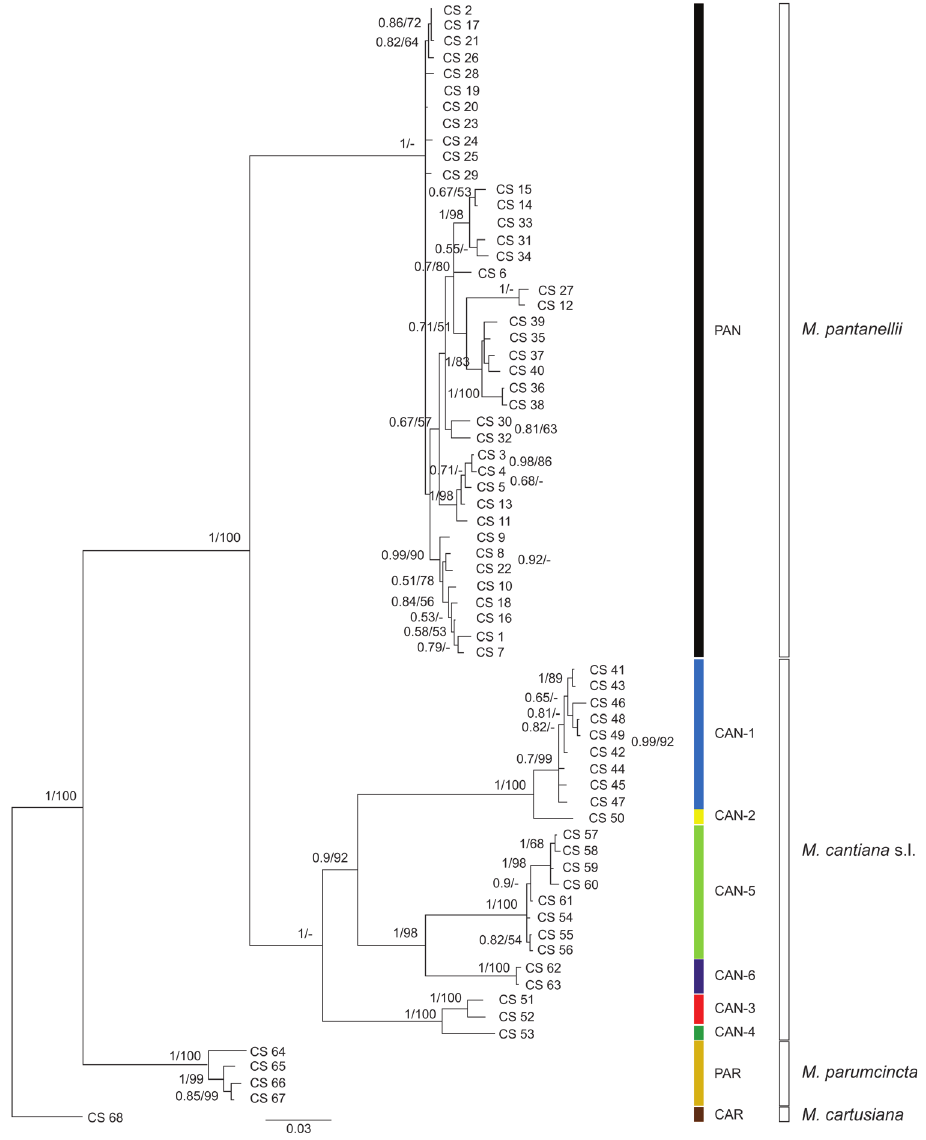
Figure 4. Bayesian 50% majority-rule consensus tree of the concatenated data set of COI and 16S rDNA haplotypes, and ITS2 and H3 common sequences (see Table 4). Sequences of M. pantanellii were compared with appropriate sequences of M. cantiana s. l. and M. parumcincta obtained from GenBank (Tables 2, 4). Posterior probabilities (left) and bootstrap support above 50% from ML analysis (right) are indicated next to the branches. Bootstrap analysis was run with 1000 replicates (Felsenstein 1985). The tree was rooted with M. cartusiana concatenated sequences obtained from GenBank (Table